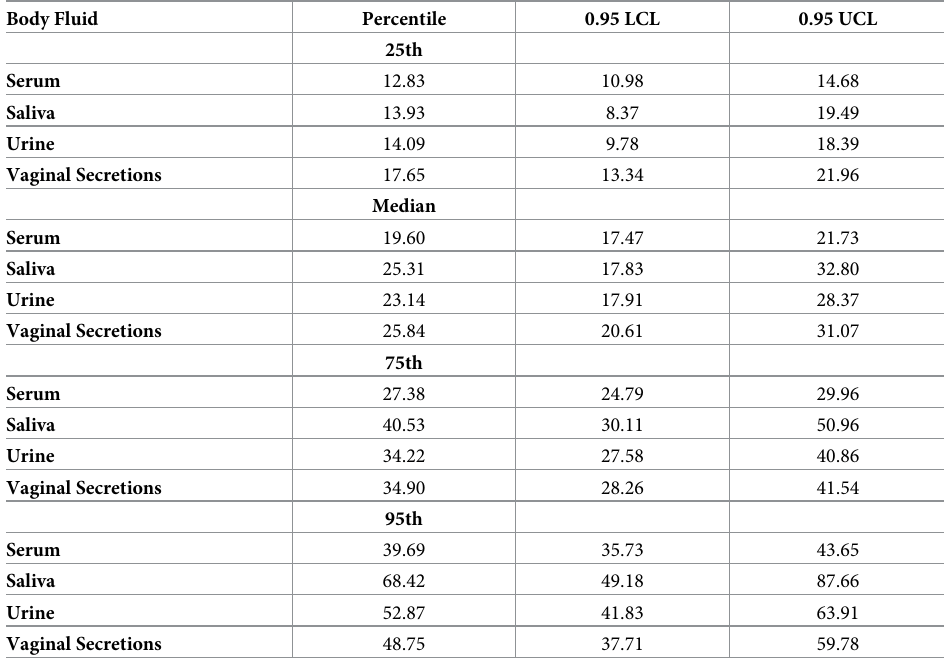
Table 4. Percentiles from the Weibull models until loss of CHIKV RNA in body fluids (in days). Body Fluid